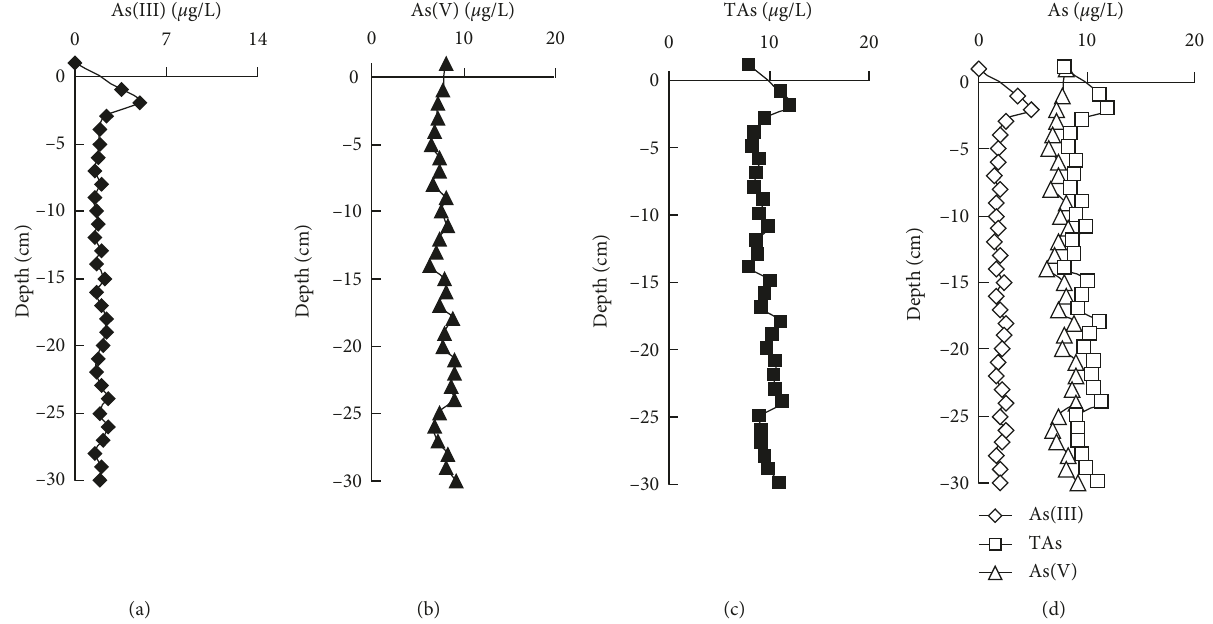
Figure 6: Profiles of dissolved As(III) (a), As(V) (b), and TAs (c) in porewaters and their comparison